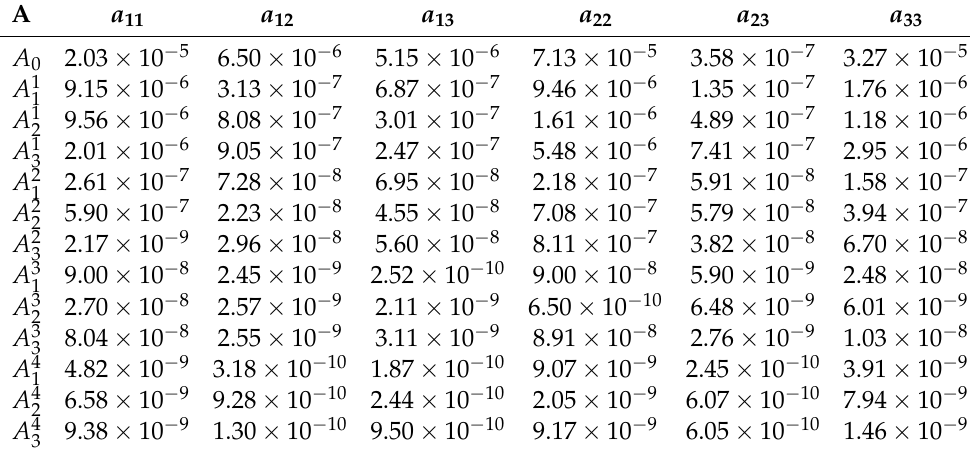
Table A2. The polynomial coefficients in the random quaternary interdiffusion system, where a ij represents the entries in the coefficient matrix on position { i , j } , i = 1, 2, 3; j = 1, 2 ,3.